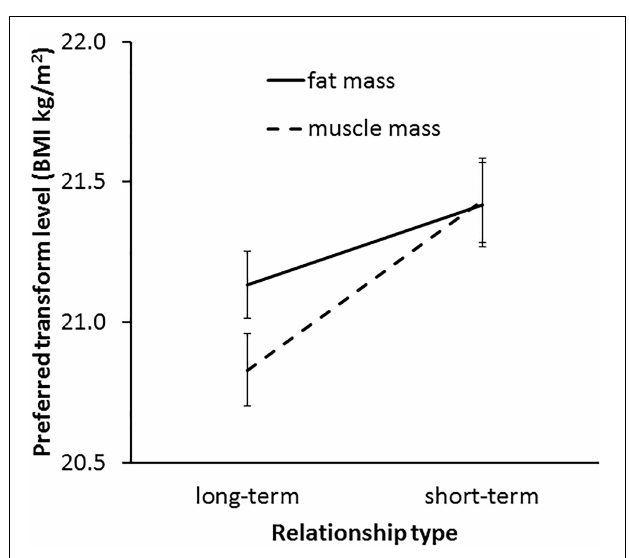
FIGURE 8 | The interaction between relationship type (short-term and long-term) and preferred facial correlates of body composition (fat mass and muscle mass) in student participants. The vertical axis represents the associated BMI of the most preferred faces. Error bars represent standard